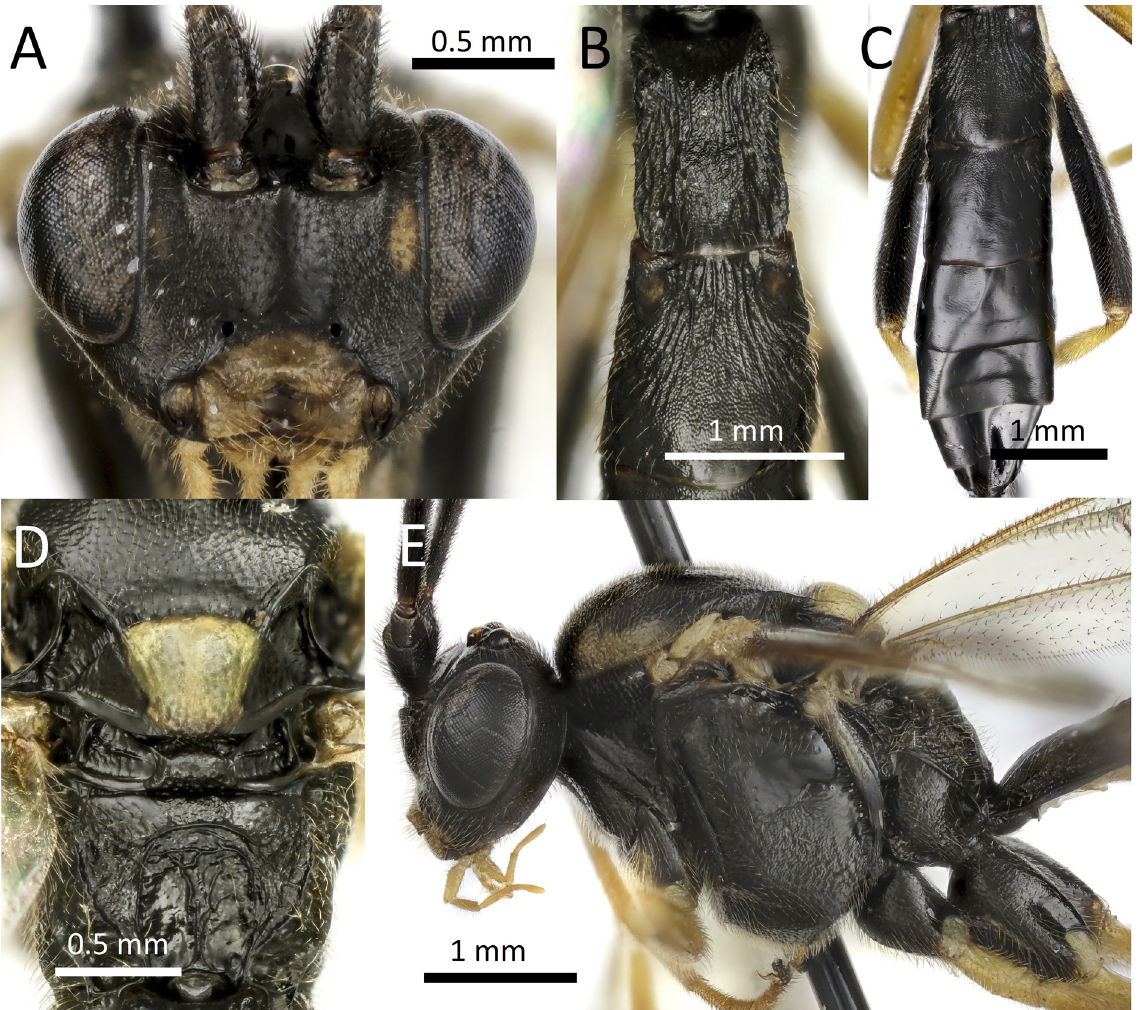
Fig. 4. Homotropus klopfsteinae sp. nov., holotype, ♀ (NHRS-HEVA000011629). A . Head anterior view. B . First and second tergites, dorsal view. C . Tergites 2–7, dorsal view. D . Scutellum and propodeum, dorsal view. E . Head and mesosoma, lateral